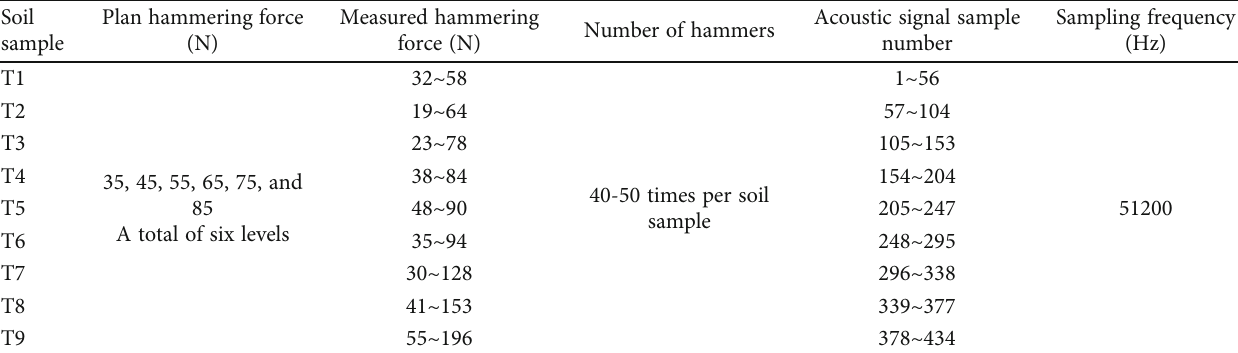
Figure 2: Hammering process. Table 2: Soil sample hammering